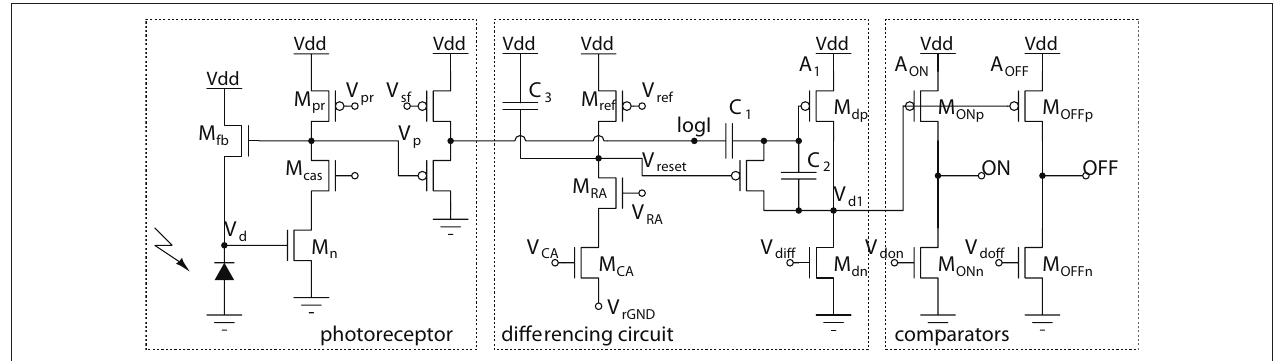
. The mismatches in the refr